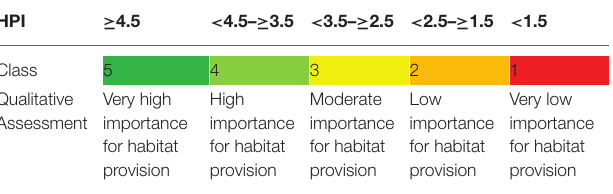
TABLE 5 | Translation of the calculated habitat provision values into the classes. HPI ≥